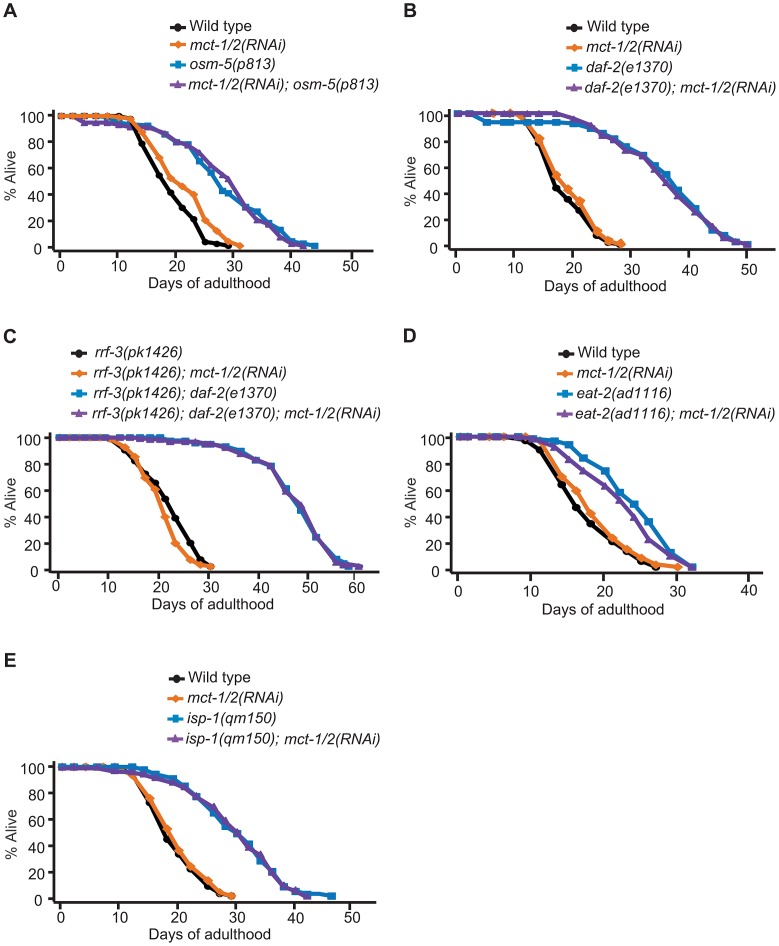

mct-1/2 is dispensable for the longevity of various long-lived mutants.Reduction of mct-1/2 levels by RNAi did not shorten the lifespan of osm-5(p813) sensory mutants (3 out of 4 times) (A), daf-2(e1370) mutants in either rrf-3(+) (B) or rrf-3(−) (C) backgrounds, dietary-restricted eat-2(ad1116) animals (D) or mitochondrial respiration-impaired isp-1(qm150) mutants (E). A summary of the data presented in this figure and additional repeats is included in Table S1B.